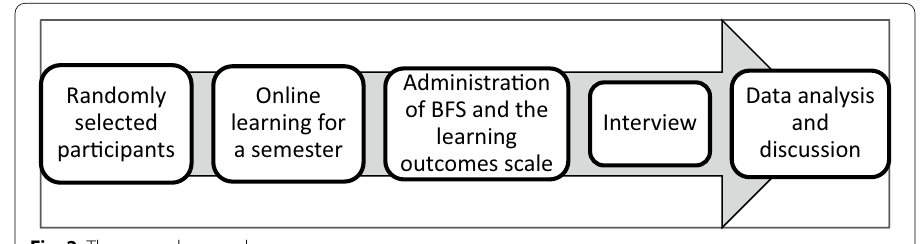
Fig. 2 The research